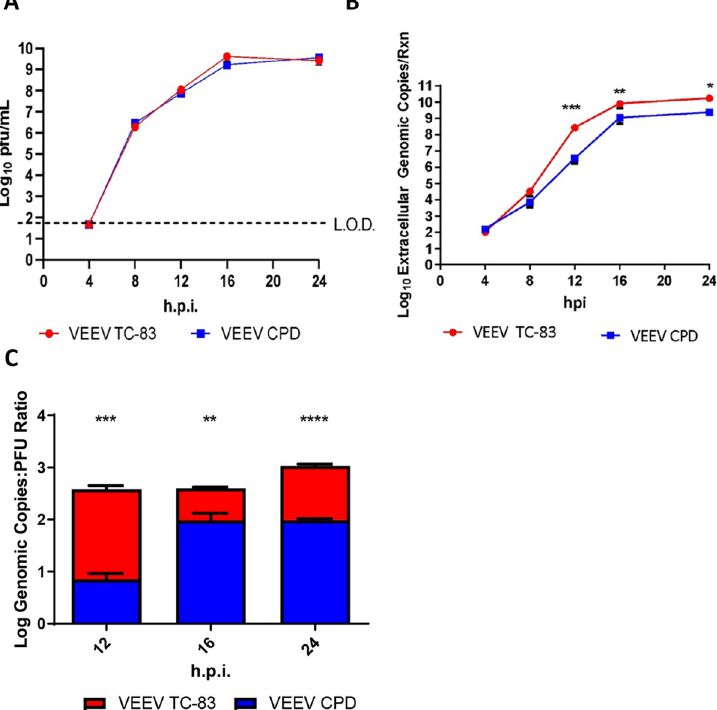
Fig 6. VEEV CPD is more infectious than VEEV TC-83. Vero cells were infected with either VEEV TC-83 or VEEV CPD (MOI 0.1) and viral supernatants collected at the indicated time points for viral titer determination via A) plaque assay or B) RT-qPCR. C). Genomic copies:PFU ratio was calculated at the indicated time points by converting RT- qPCR genomic copy per reaction data to genomic copies per milliliter. Genomic copies per milliliter were then divided by PFU/mL of the respective time point to obtain the genomic copies to PFU ratio. Values are an average of 3 biological replicates ± standard deviation. � = p < 0.05, �� = p < 0.005, ��� = p < 0.0005, ���� = p <